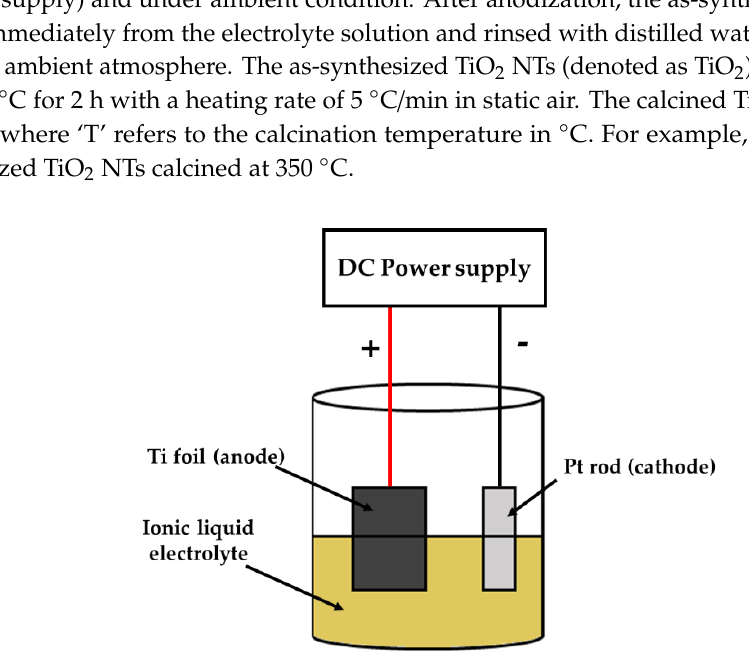
Figure 2. Schematic diagram of the anodization setup.